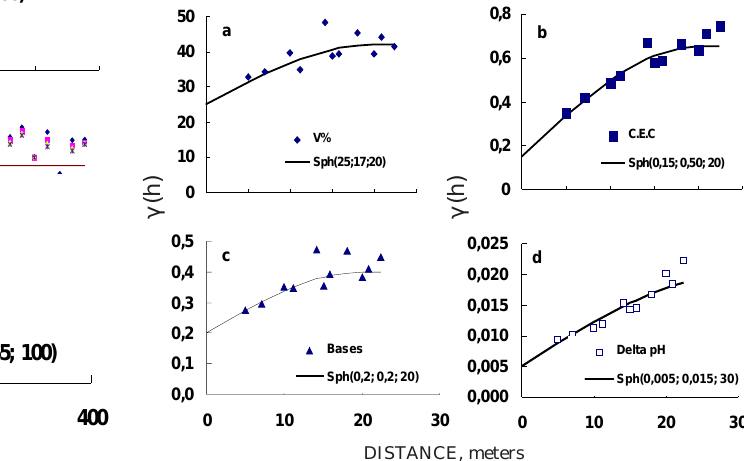
Figure 1. Semivariograms for maximum daily rainfall in São Paulo. a) On a log scale; b) For maximum daily rainfall at 10 years return period; c) Scaled semivariograms with a single model.